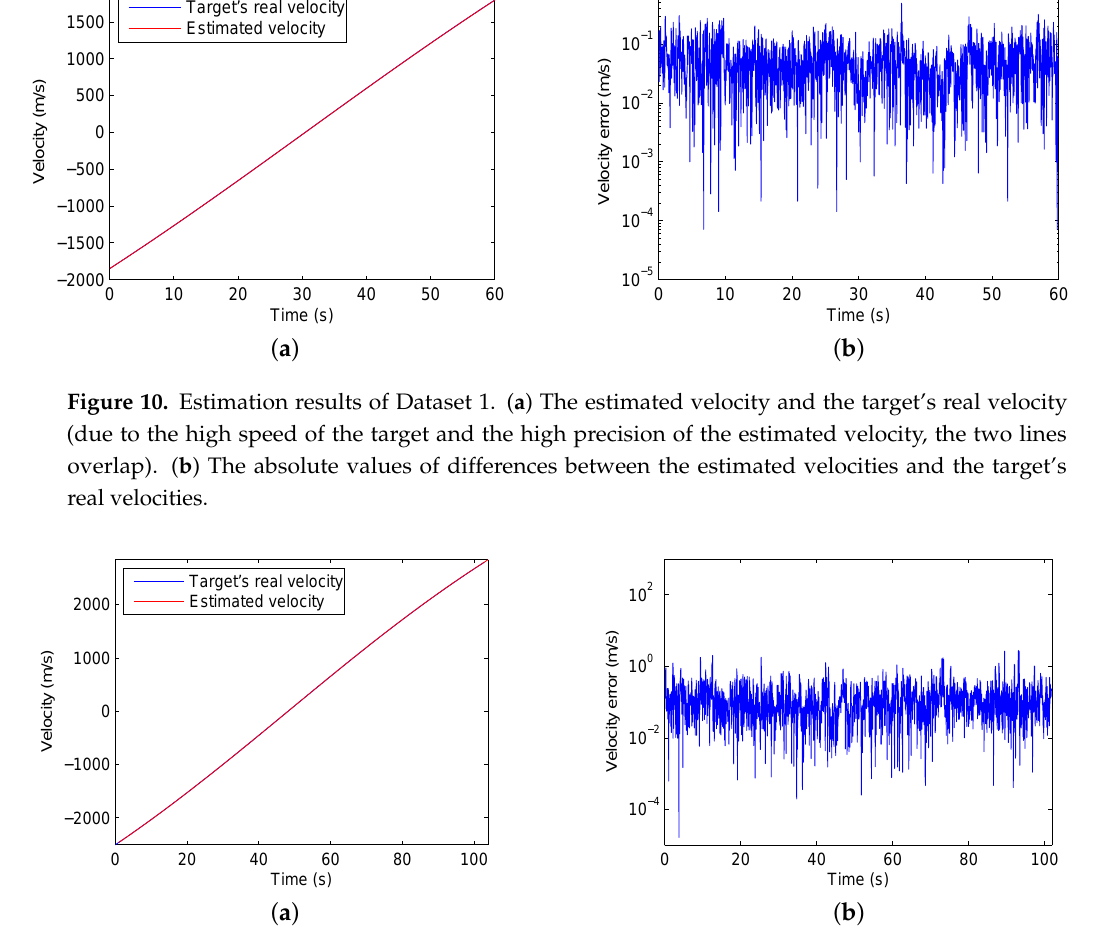
Figure 11. Estimation results of Dataset 2. ( a ) The estimated velocity and real velocity of the target (due to the high speed of the target and the high precision of the estimated velocity, the two lines overlap). ( b ) The absolute values of differences between the estimated velocities and the target’s real velocities. Table 5. Parameters of